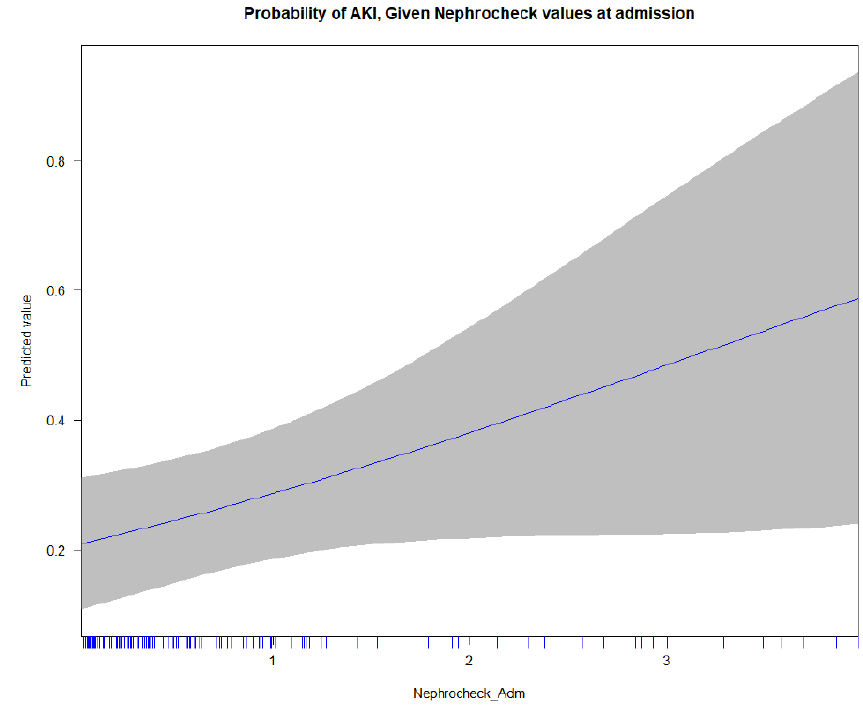
Figure 4. Probability of AKI given NephroCheck admission values.